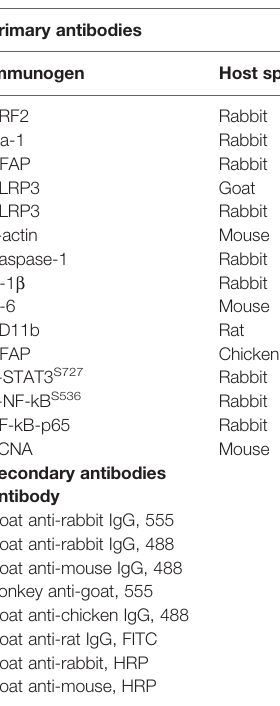
TABLE 1 | List of antibodies used in this